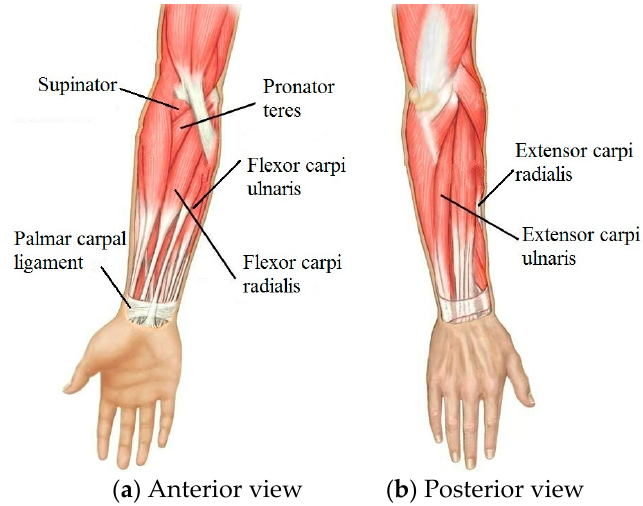
Figure 3. The anatomy of wrist-related muscles: ( a ) Anterior view; ( b ) Posterior view.